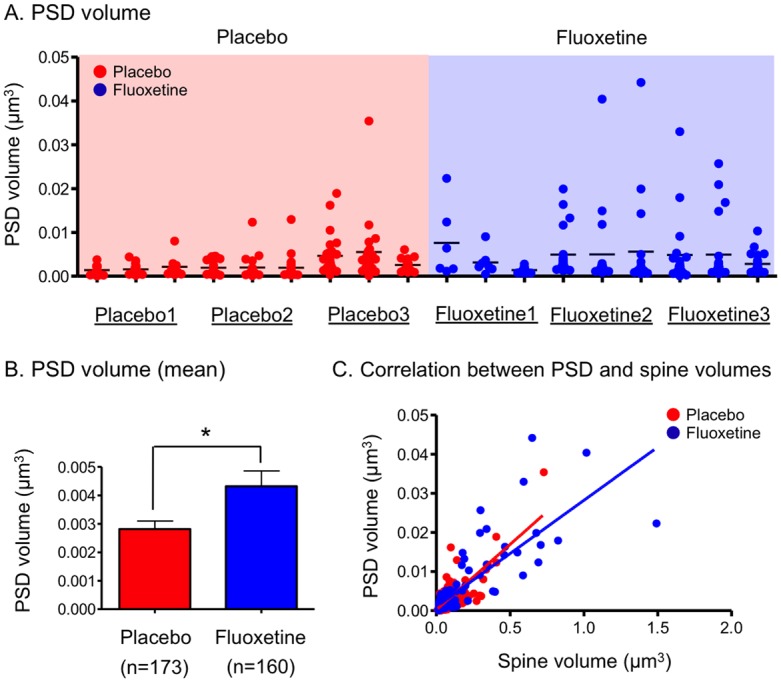
PSD volume and its correlation with spine volume.(A) Scatter plot showing the PSD volume in mice treated with placebo (n = 173 PSDs from 9 dendrites, 3 dendrites per each of 3 mice) or fluoxetine (n = 160 PSDs from 9 dendrites, 3 dendrites per each of 3 mice). (B) Mean values of the PSD volume in the placebo- and fluoxetine-treated mice. *p < 0.05 compared with placebo-treated mice; Mann-Whitney U-test (U = 11920, p = 0.0284). (C) Correlation between the PSD volume and spine volume in the placebo or fluoxetine-treated mice. The fitted lines for the mice treated with placebo (r2 = 0.63, p < 0.0001) or fluoxetine (r2 = 0.64, p < 0.0001) were obtained through a linear regression analysis.